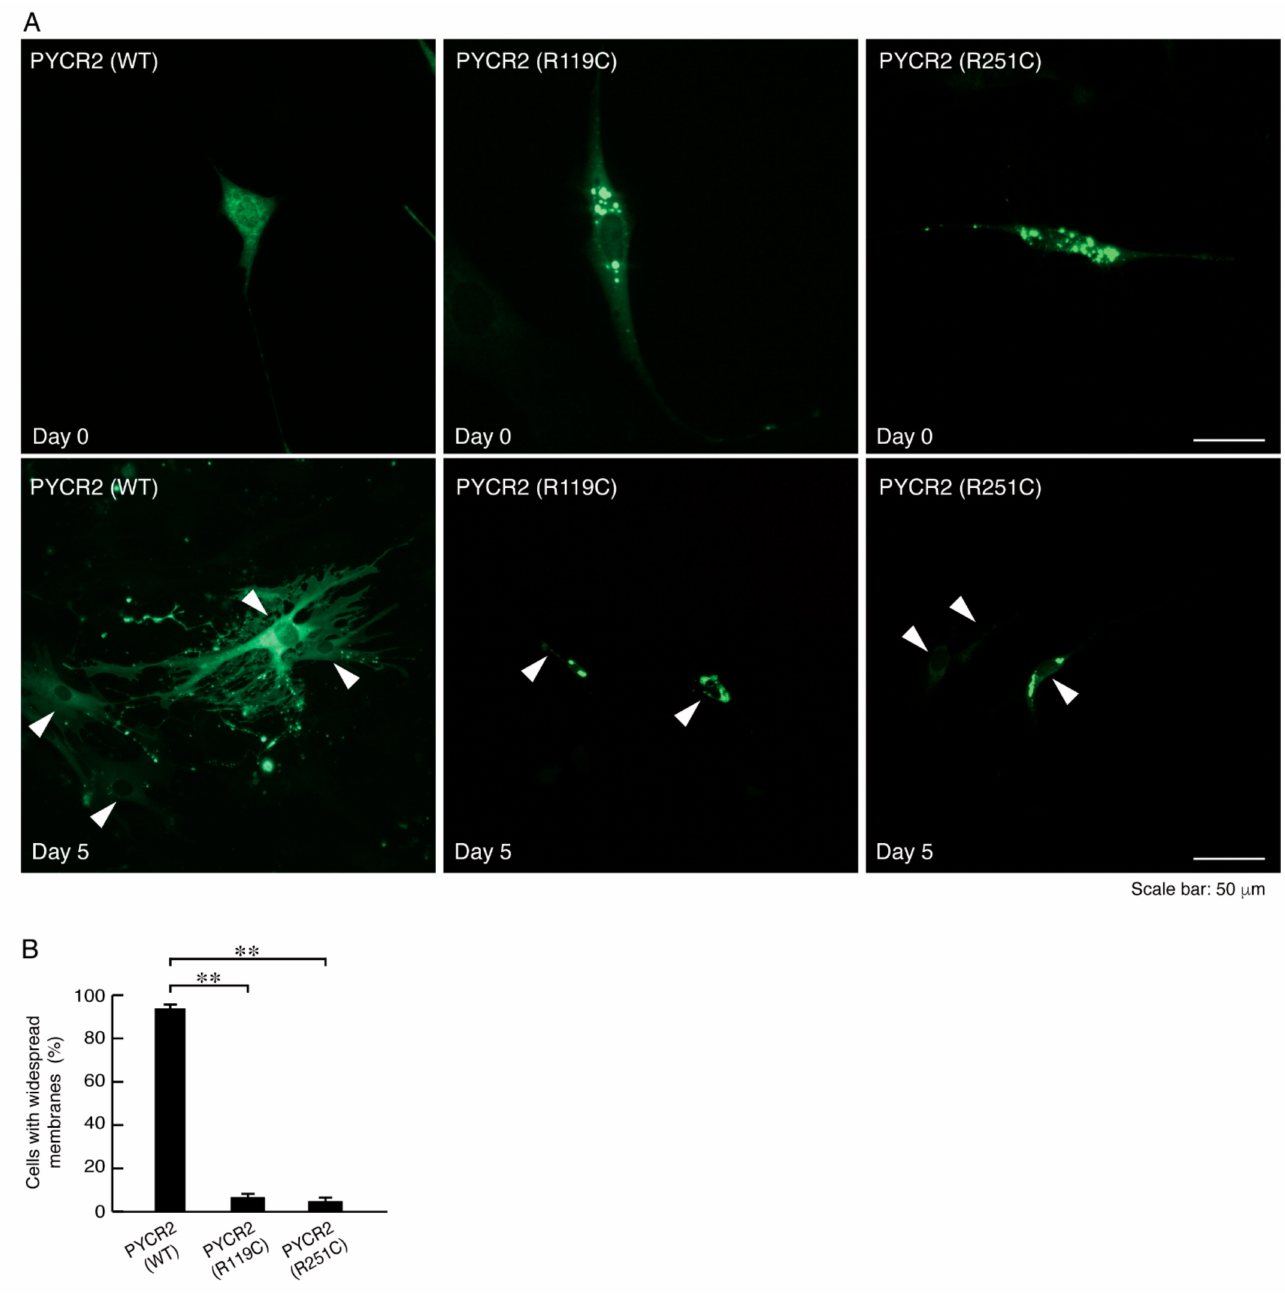
Figure 8. Cells expressing the R119C or R251C proteins, but not the wild type proteins, fail to exhibit oligodindroglial cell morphological differentiation. ( A , B ) FBD-102b cells expressing the R119C, R251C proteins, or the wild type proteins were allowed to differentiate for 0 or 5 days. Arrowheads indicate typical differentiated cells with widespread membranes in cells expressing the wild type proteins and undifferentiated cells in cells expressing the R119C or R251C proteins. Differentiated cells were statistically assessed (**, p < 0.01; n = 10